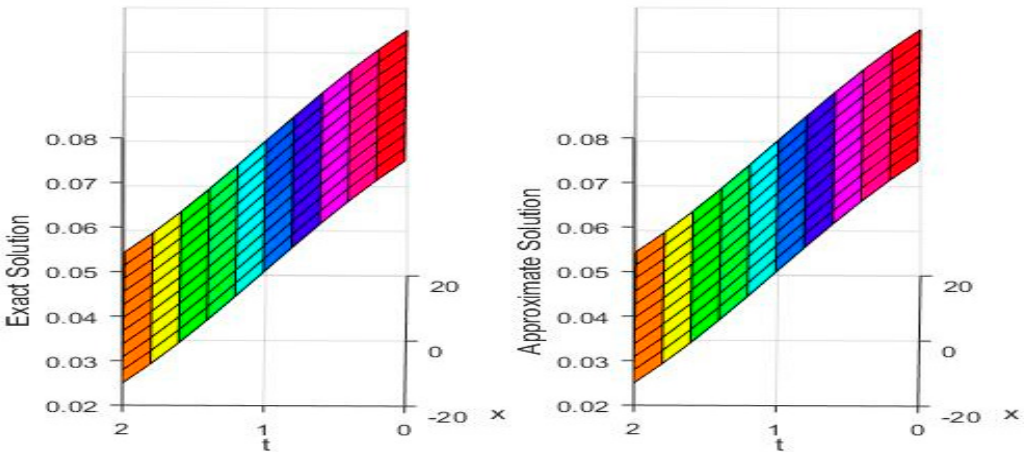
Figure 1. Behavior of exact ( Left ) and approximate solutions ( Right ) of 𝑢 for Test Problem 1.